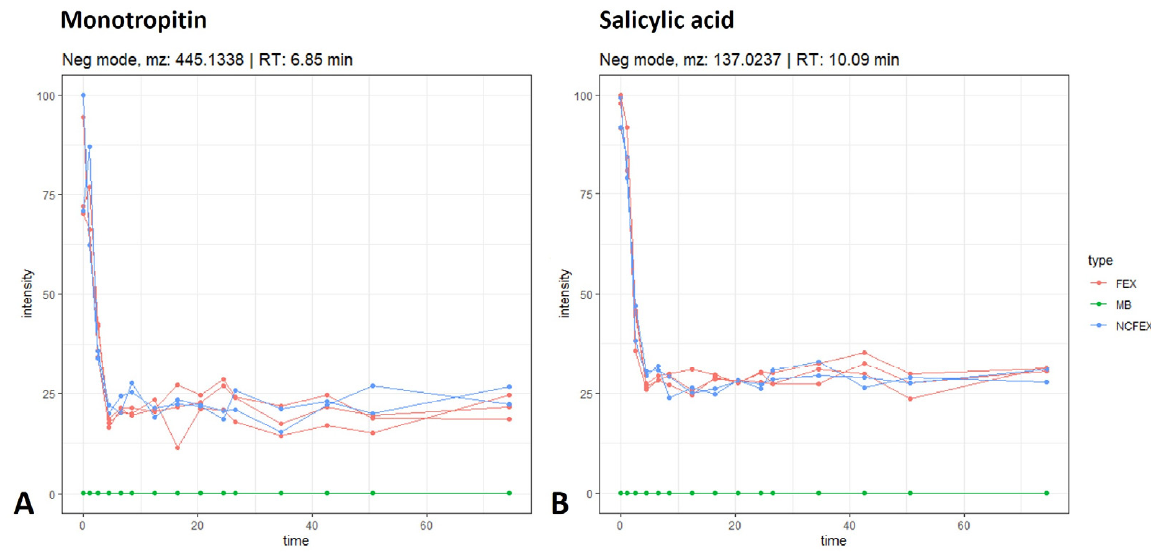
Figure 6. Time profiles (time in hours) of monotropitin ( A ) and salicylic acid ( B ) during gastrointestinal biotransformation. See also legend of Figure 2.